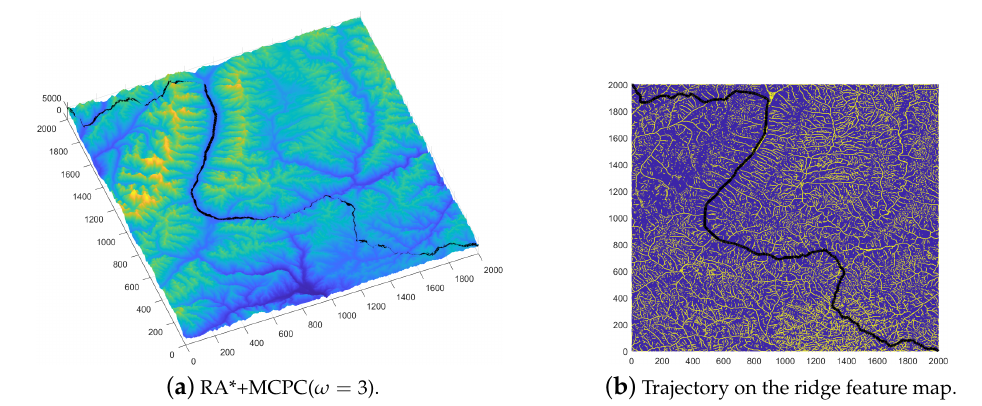
Figure 14. Case study of our